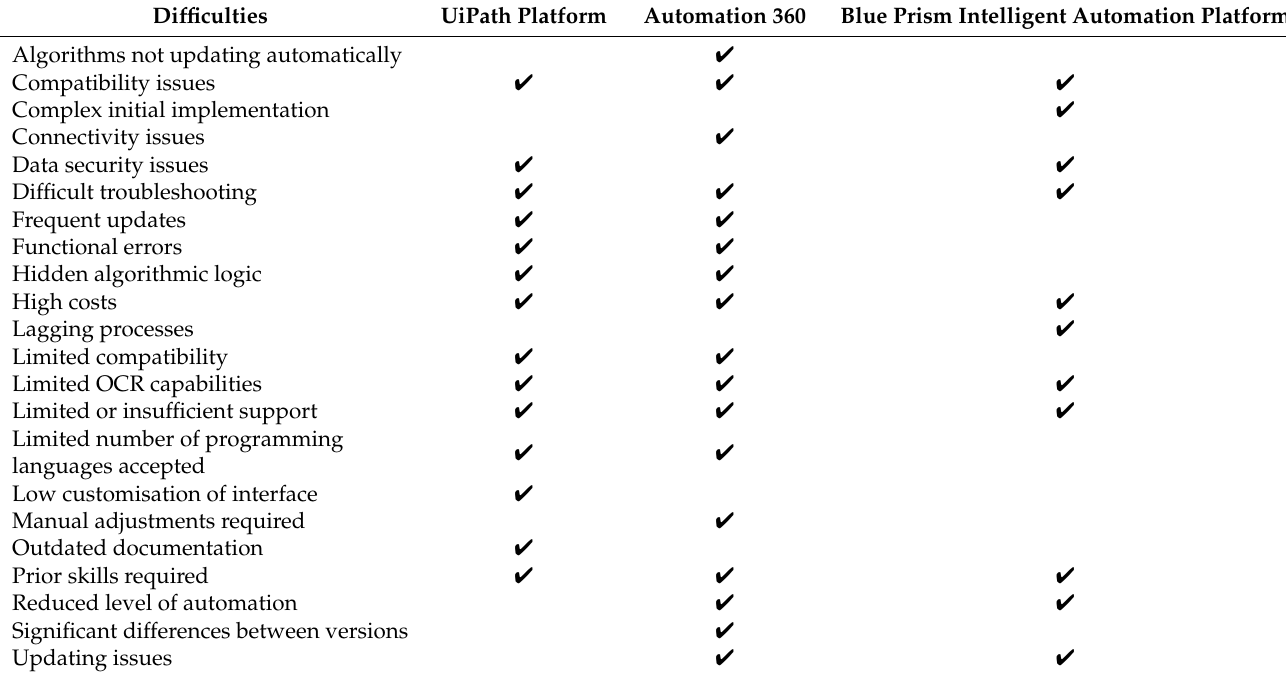
Table 7. Main challenges encountered by